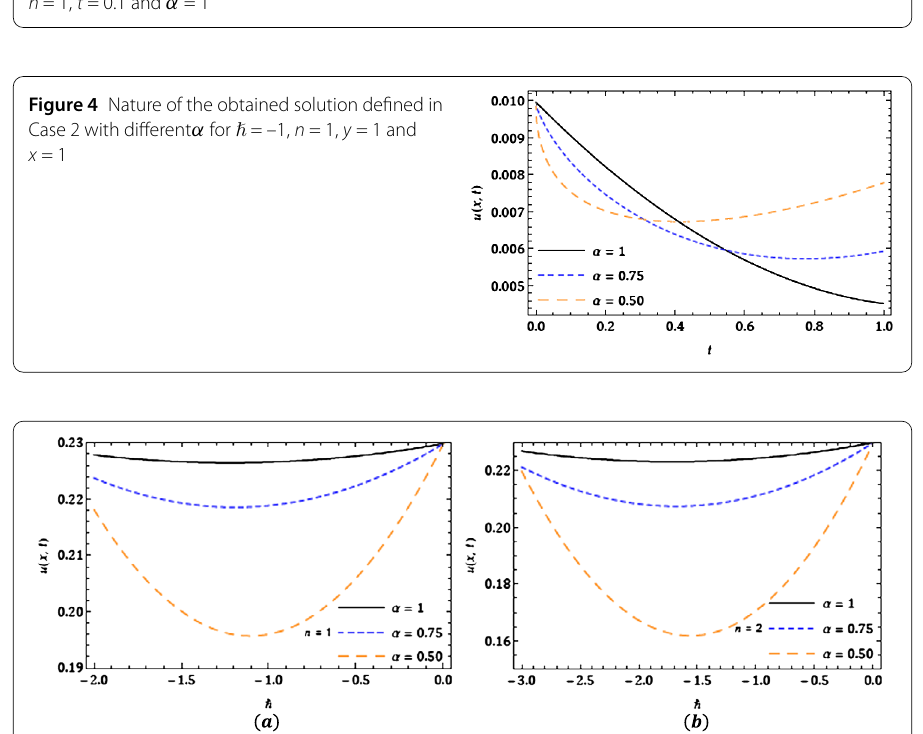
Figure 5 (cid:2) -curves for q -HATM solution considered in Case 2 with different α for x = 1, y = 1 and t = 0.01 with ( a ) n = 1 and ( b ) n = 2